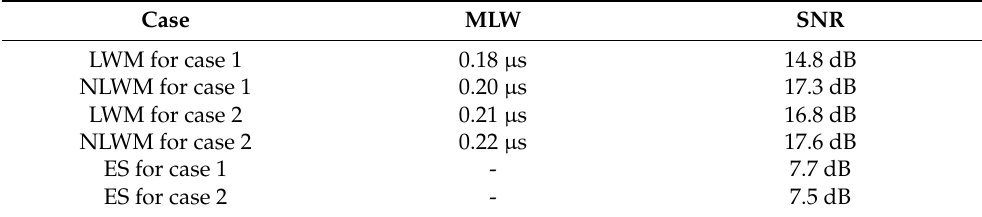
Table 1. MLW and SNR in the experiment.